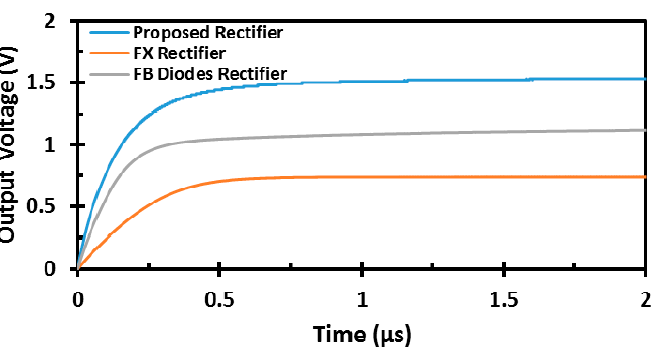
Figure 8. Transient simulation of the output DC voltage for the different architectures at − 15 dBm input RF power level for a load capacitance of 0.1 nF.